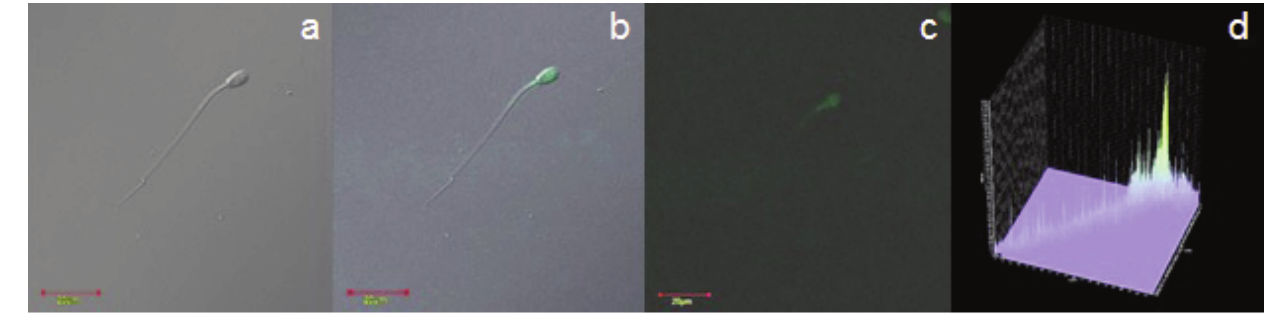
Figure 3. Ca 2+ Intensity with Fluo-3 Staining 400XZ 2.5 P0 Group (without supplementation of Contrast; b) Super Infuse; c) Fluorescence; d) Ca 2+ Intensity.